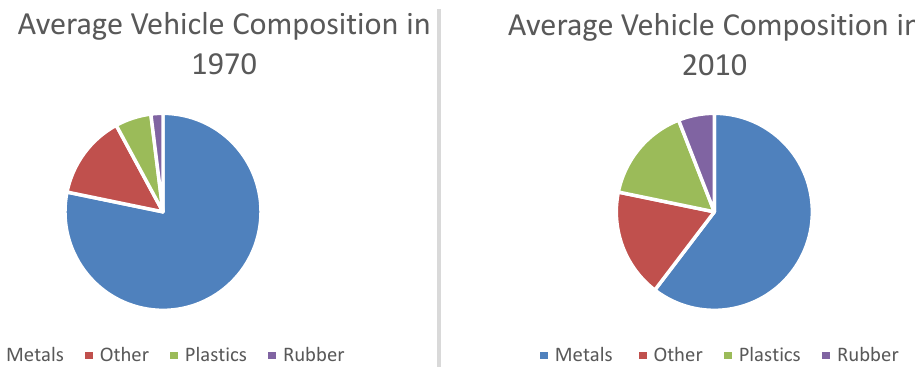
Figure 1. Change in vehicle composition from 1970 to 2010